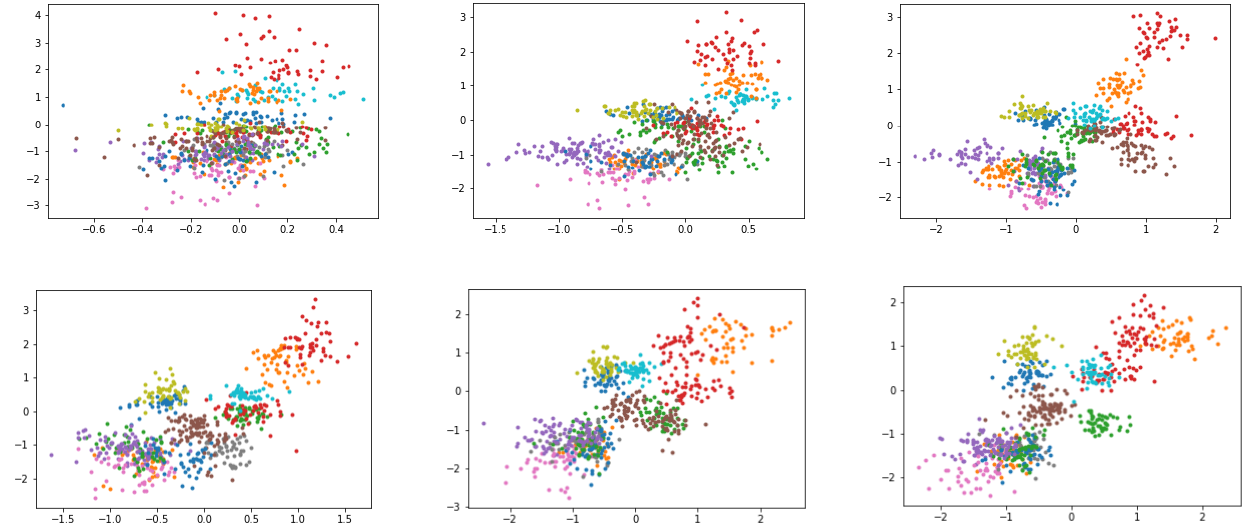
Figure 11. Visualisation of the compressed representation through the training cycle. Each colour represents elements in the compressed dimension. This result was obtained by training the model with a 16-dimensional compressed representation to make the visualisation more expressive.